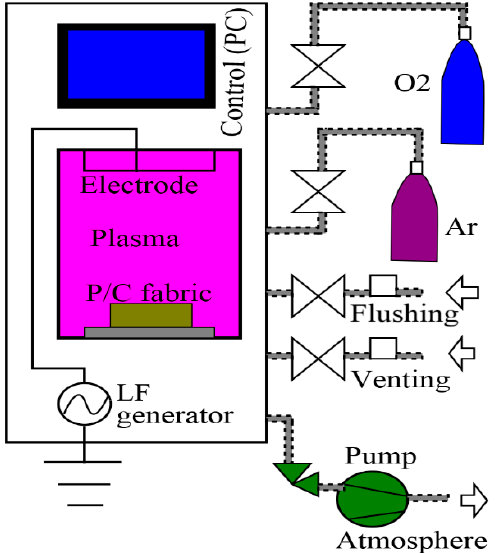
Figure 1. Schematic diagram of vacuum plasma system (Tetra 30 PC).